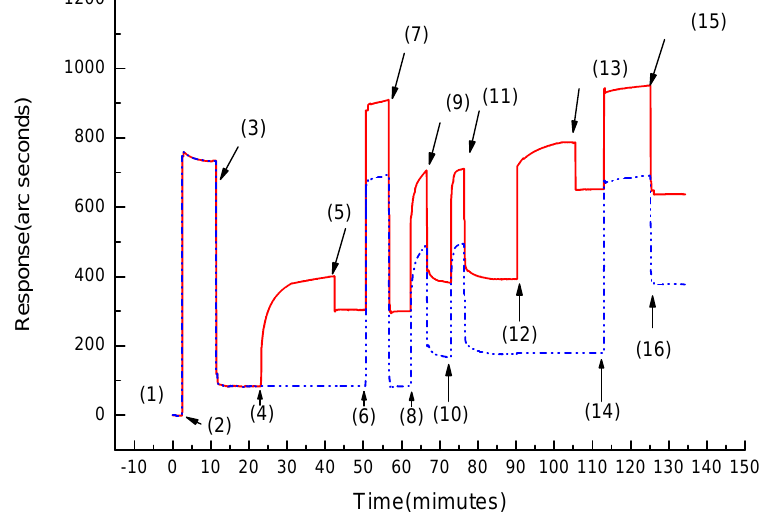
Figure 1. Resonance response of IAsys to the ET-1 immobilized CMD cuvette and binding detection of P. radix 801(pH 7.4 PBST, 0.18 mg mL -1 ET-1, 5 mg mL -1 P. radix